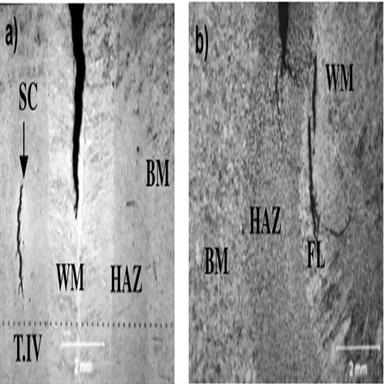
Occurrence of second crack in P91 EBW joints at 600 ◦C with starter notch in (a) WM and (b) HAZ .